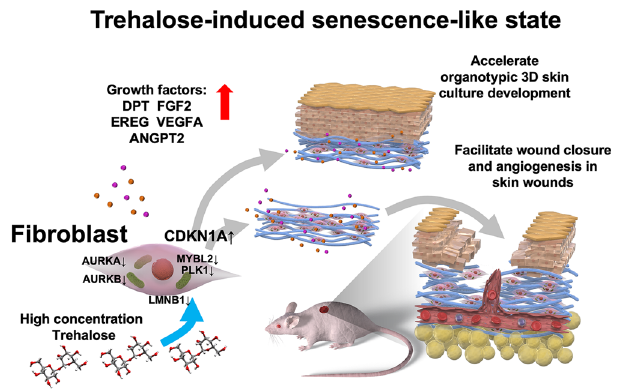
Fig. 10 Trehalose-induced senescence-like state. Highly concentrated trehalose-induced transient senescence-like state accelerates organotypic skin culture generation and facilitates cutaneous wound